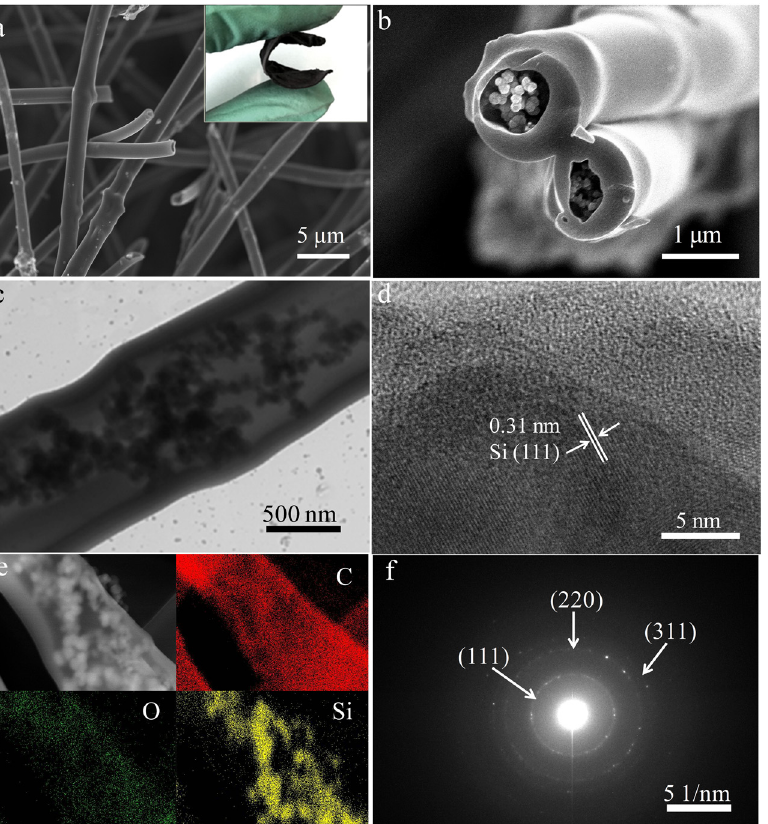
Figure 2: ( a and b ) SEM images ( the inset is an optical image of Si@CNF under bending ) , ( c ) TEM image, ( d ) HRTEM image of Si@CNF, ( e ) EDX elemental mappings of carbon, silicon and oxygen and ( f ) SAED